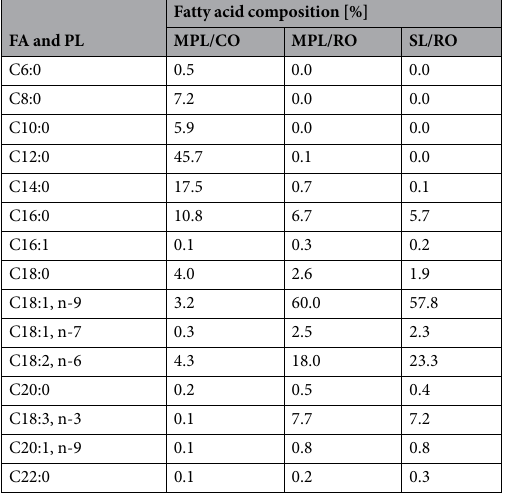
Table 1. Fatty acid content in emulsions illustrated as percentage-wise